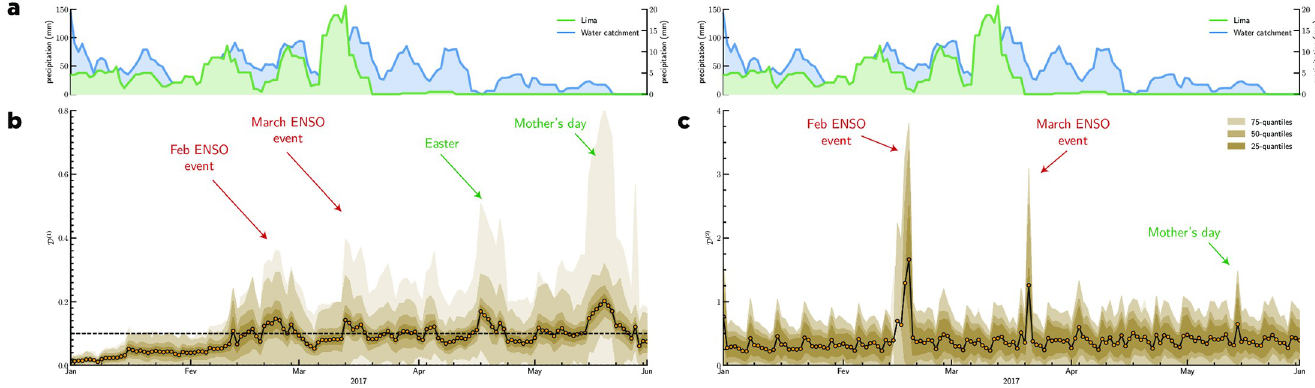
Fig 2. Divergence D ð 1 Þ and D ð 2 Þ of various districts of Lima. The average divergence over all districts of Lima as well as the 25th, 50th, and 75th quantiles are plotted in different shades of brown. a ) sliding window of 7 cumulative rainfalls over Lima city (in green) and the water catchment area of Lima’s rivers (in blue); the right y- axis represents 7 days cumulative rainfall over the water catchment area of Lima’s rivers (blue) and the left y-axis represents the 7 days cumulative rainfall over the area of Lima (green); the data were obtained from the Center for Hydrometeorology and Remote Sensing (CHRS) Data Portal [24]. b ) Divergence D ð 1 Þ . c ) Divergence D ð 2 Þ .